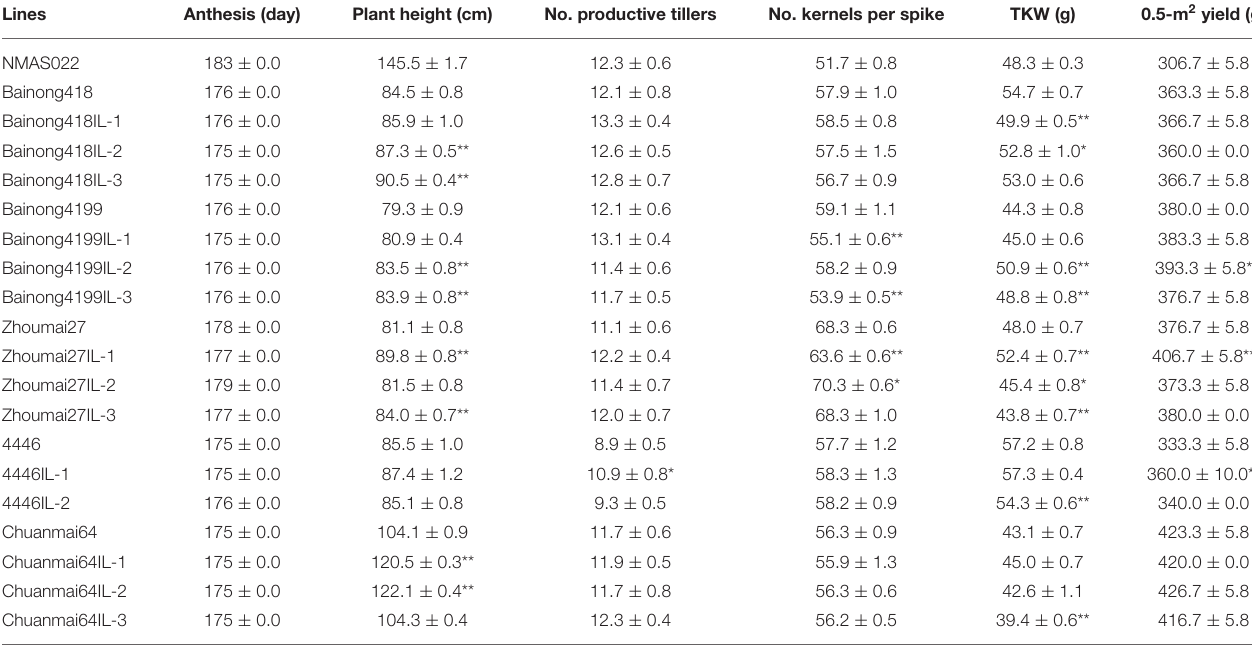
TABLE 3 | Agronomic traits (represented as mean ± SD) of the WSB Fhb1 , Fhb4 , and Fhb5 introgression lines and the parents.